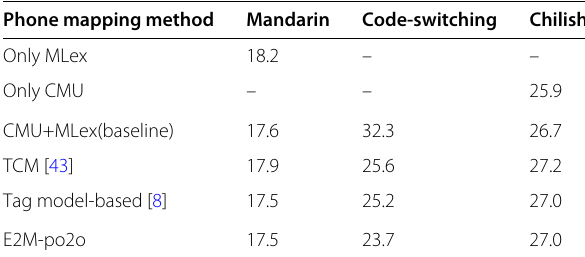
Table 2 Performance comparison(TER%) on and code-switching test sets from GMM-HMM systems with different phone mapping methods